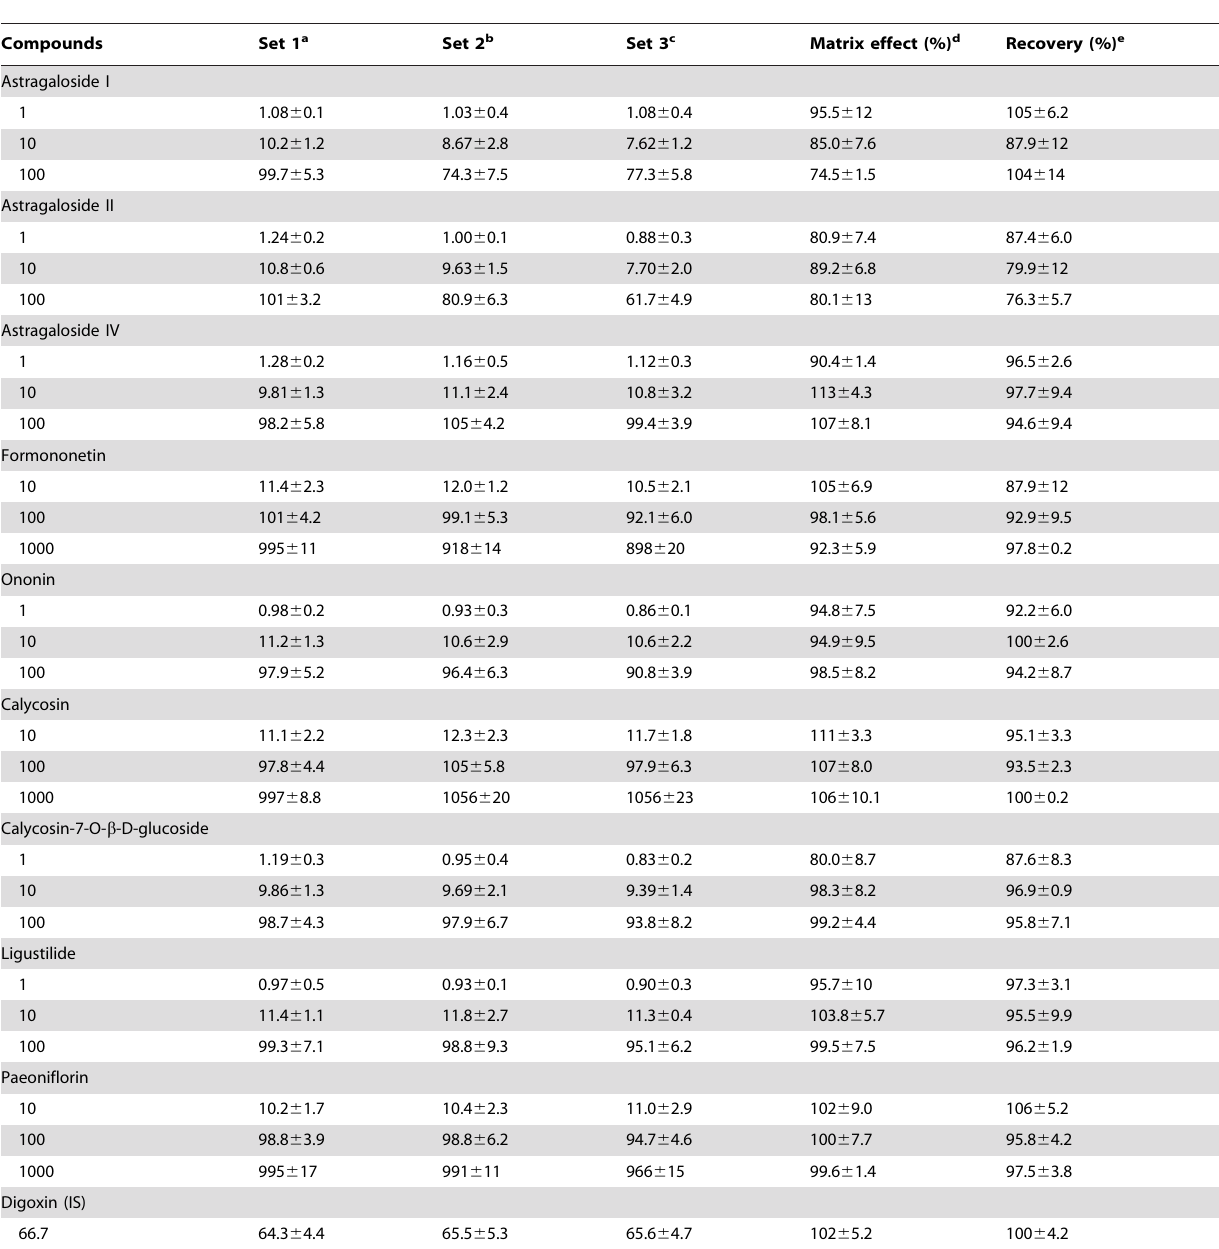
Table 3. Extraction recovery and matrix effect of nine compounds and internal standard in rat plasma.